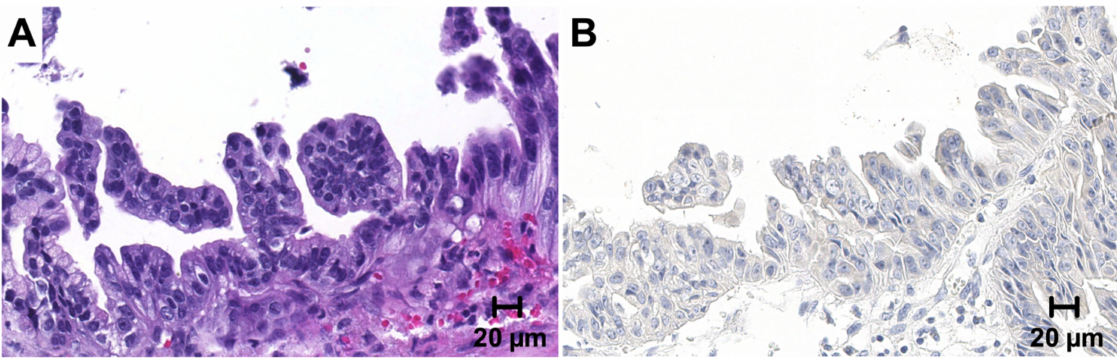
Figure 2. PD-L1 immunohistochemistry in high-grade biliary intraepithelial neoplasia. PD-L1 expression was also assessed in a number of 74 concomitant high-grade biliary intraepithelial neoplasia (BilIN) precursor lesions. ( A ) (HE). All BilIN lesions showed complete negativity for PD-L1 ( B ). Original magnification 400 × .